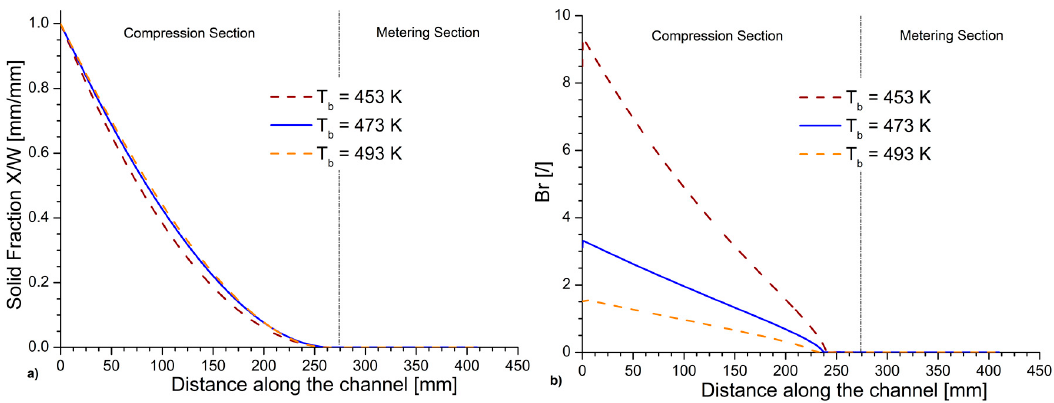
Figure 7. ( a ) Melting profile for di ff erent barrel temperatures considering otherwise the micro-extrusion settings and material parameters of Table 1 (Column 2); and ( b ) associated Brinkman numbers. Blue (reference) lines as in Figure 4.